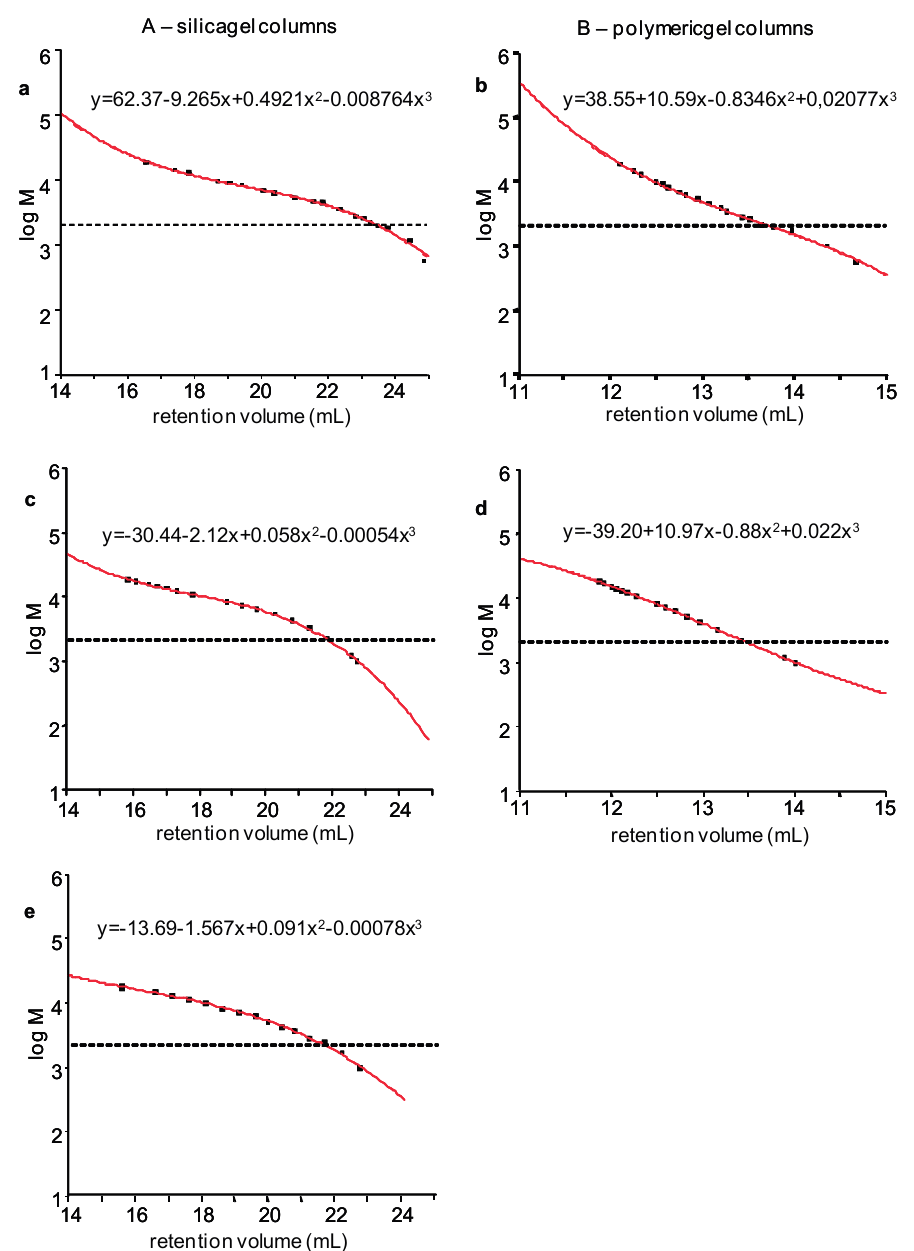
Figure 2. Typical calibration curves of (A) silica gel columns with narrow fractions ( a ), broad γ -hep ( c ) and EP method ( e ), and (B) polymeric gel columns with narrow fractions ( b ) and broad γ -hep ( d